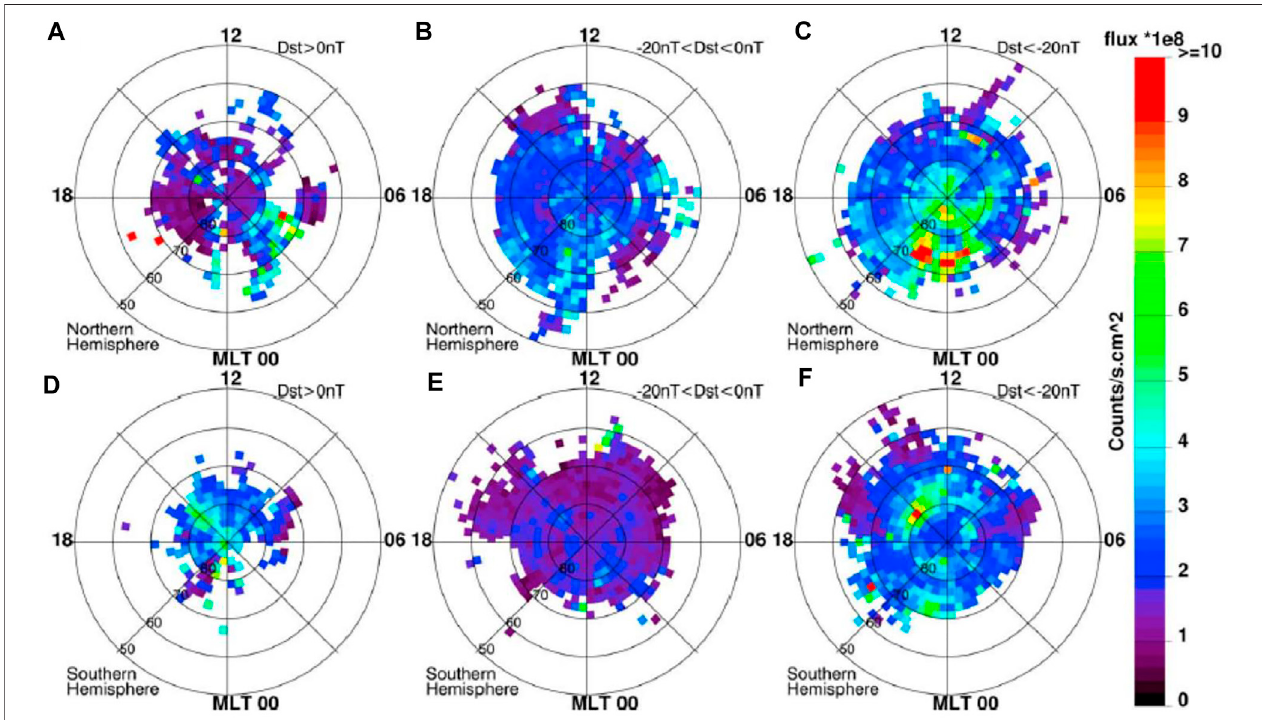
FIGURE3| Coldionout fl ow fl uxinthenorthern (A – C) andthesouthern (D – F) hemispheres.Foreachhemisphere,thethreepanelsfromlefttorightshowthe fl uxes under quiet, moderate, and disturbed geomagnetic conditions, respectively. Each colored pixel indicates the mean fl ux. From Li et al., (2012).